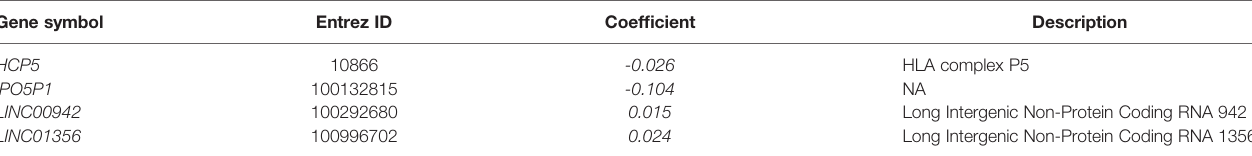
TABLE 1 | Description of the four modeling genes.